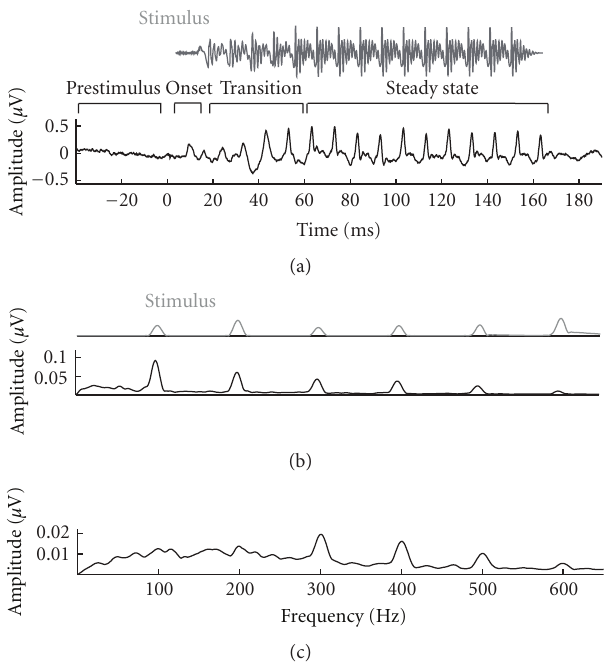
Figure 1: The stimulus /da/ (gray) is displayed with its response (black) in time and frequency domains. (a) Time domain. The response represents an average of 17 older adults (ages 60 to 67) all of whom have audiometrically normal hearing. The periodicity of the stimulus is reflected in the response with peaks repeating every ∼ 10ms (the 𝐹 0 of the vowel /a/). (b) and (c) Frequency domain. Fast Fourier transforms were calculated over the steady-state region of the response, showing frequency energy at the 𝐹 0 (100Hz) and its integer harmonics for responses obtained by adding (b) and subtracting (c) responses to alternating